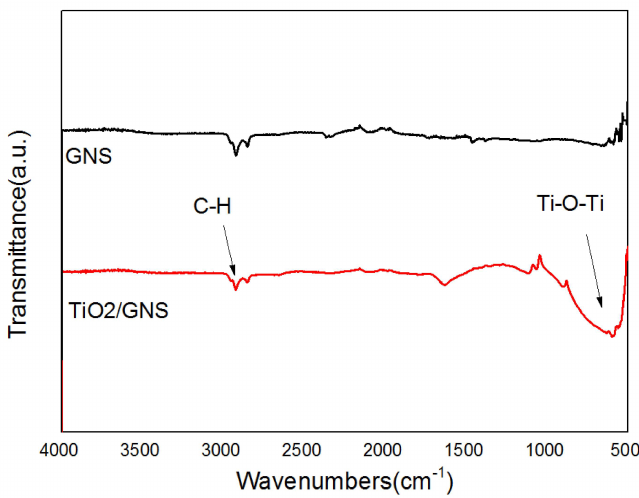
Figure 5. FTIR spectra of raw GNs and TiO 2 /GNs.